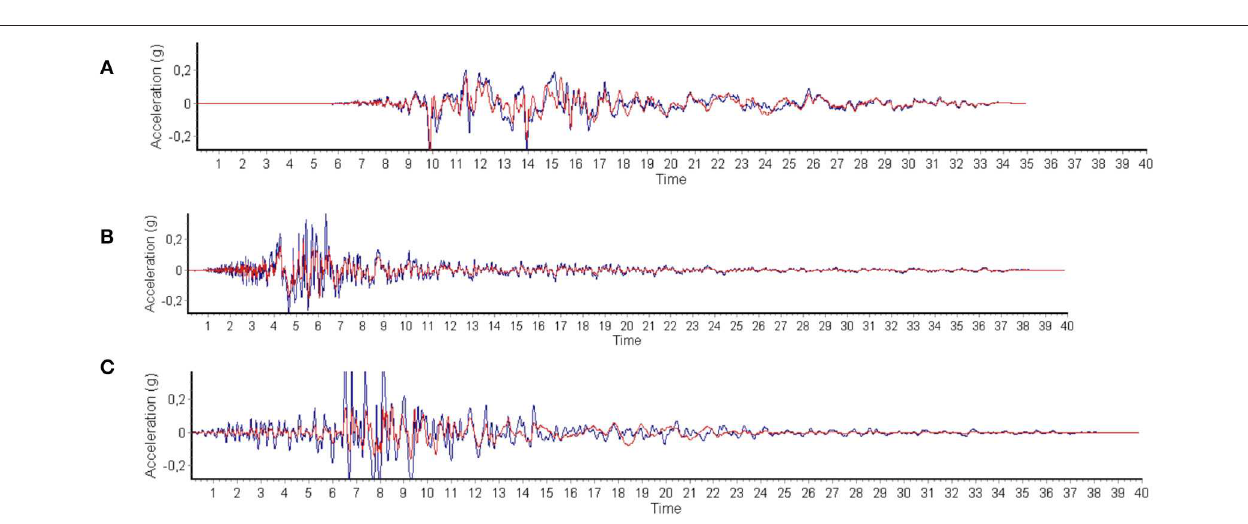
FIGURE 10 | Time histories used for dynamic analyses: (A) Kocaeli (1999), (B) Northridge (1994), and (C) Loma Prieta (1989), with blue and red indicating the original and the scaled accelerograms,